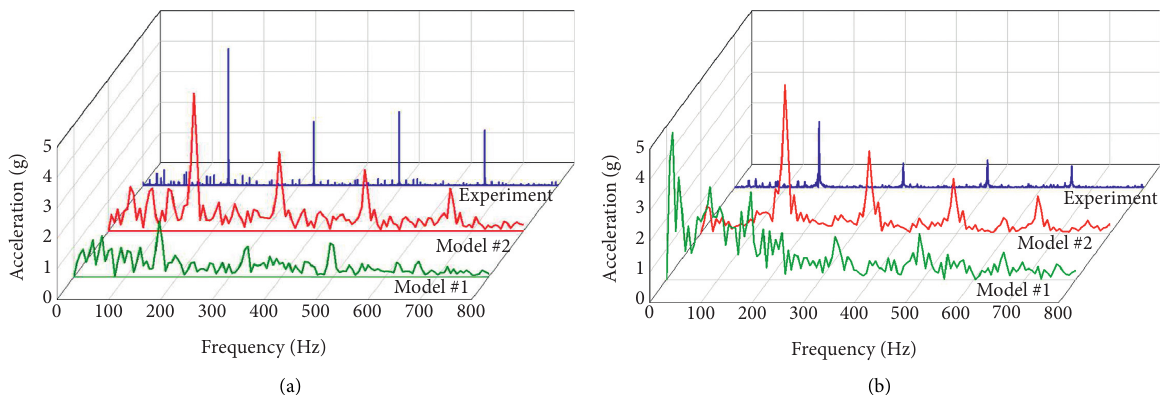
Figure 6: Envelope spectrum of the vibration signals from (a) the top surface of the bearing housing and (b) the side surface of the bearing